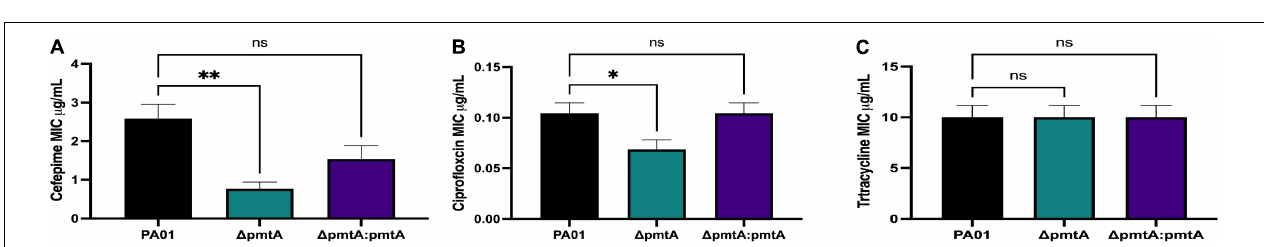
FIGURE 7 | The effects of PmtA on the Minimum Inhibitory Concentration (MIC) of cefepime, ciprofloxacin and tetracycline. Single colonies from the wild-type, (cid:49) pmtA , and (cid:49) pmtA:pmtA PAO1 strains were each inoculated into 1 mL of LB. A sterile cotton swab was used to spread the culture over a LB plate. Liofilchem R (cid:13) MTS E -tests were placed separately onto the plates after inoculation for cefepime (A) , ciprofloxacin (B) and tetracycline (C) . When compared to wild-type and (cid:49) pmtA : pmtA PAO1 strains, the (cid:49) pmtA mutant was significantly more susceptible to cefepime and ciprofloxacin. One-way ANOVA analysis was performed (* p < 0.05; ** p < 0.01; *** p < 0.001; **** p < 0.0001. The data are presented as the average of three biological replicates ( ± standard error of the mean) and are representative of three separate experiments.